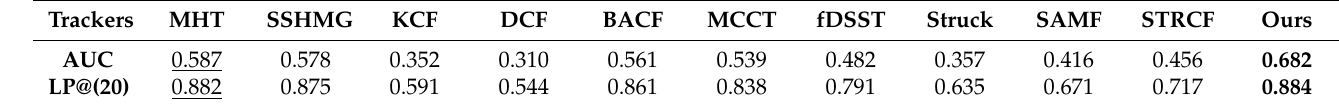
Table 2. Comparison with the state-of-the-art correlation filters’ trackers on IMEC16.